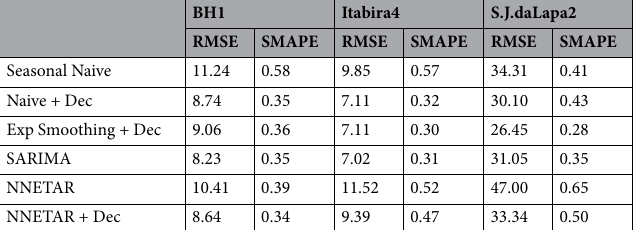
Table 2. Accuracy measures (RMSE and SMAPE) for the model forecast of each of the five considered models, in the data from the three monitoring stations, BH1, Itabira4, and S.J.daLapa2.